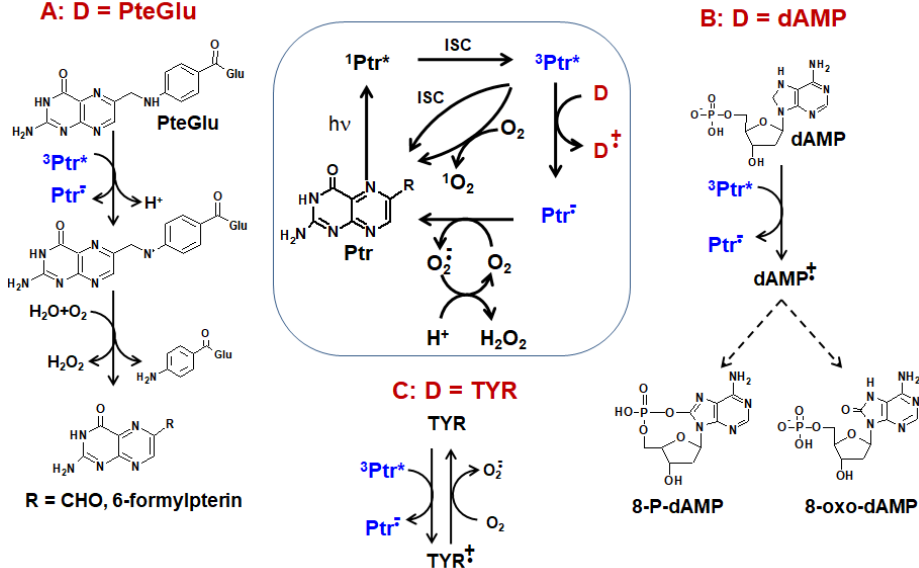
Figure 18. Schemes of pterin-sensitized electron donor oxidation. ( A ) folic acid (PteGlu) pho- tooxidation; ( B ) Deoxyadenosine monophosphate (dAMP) photooxidation; ( C ) tyrosinase (TYR) inactivation